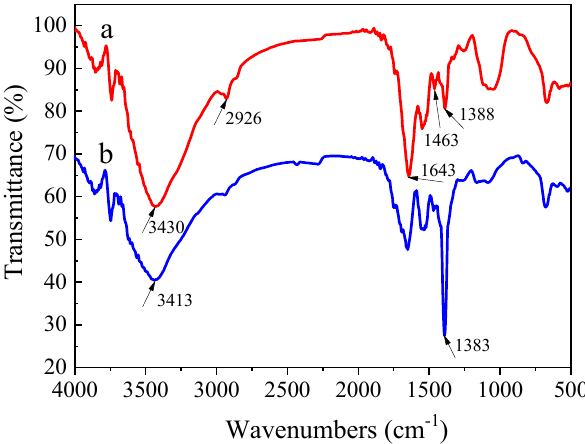
Figure 1. Fourier transform infrared spectroscopy (FTIR) spectra of the biopolymer before ( a ) and after ( b ) adsorbing Hg(II).